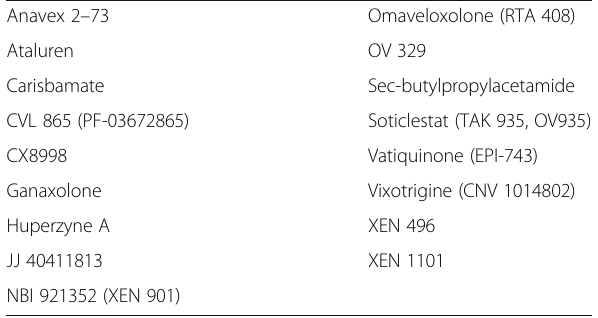
Table 3 A list of investigational drugs currently in clinical development as potential treatments for epilepsy. The list is not exhaustive and does not include medications approved for other indications and currently being tested for potential repurposing in